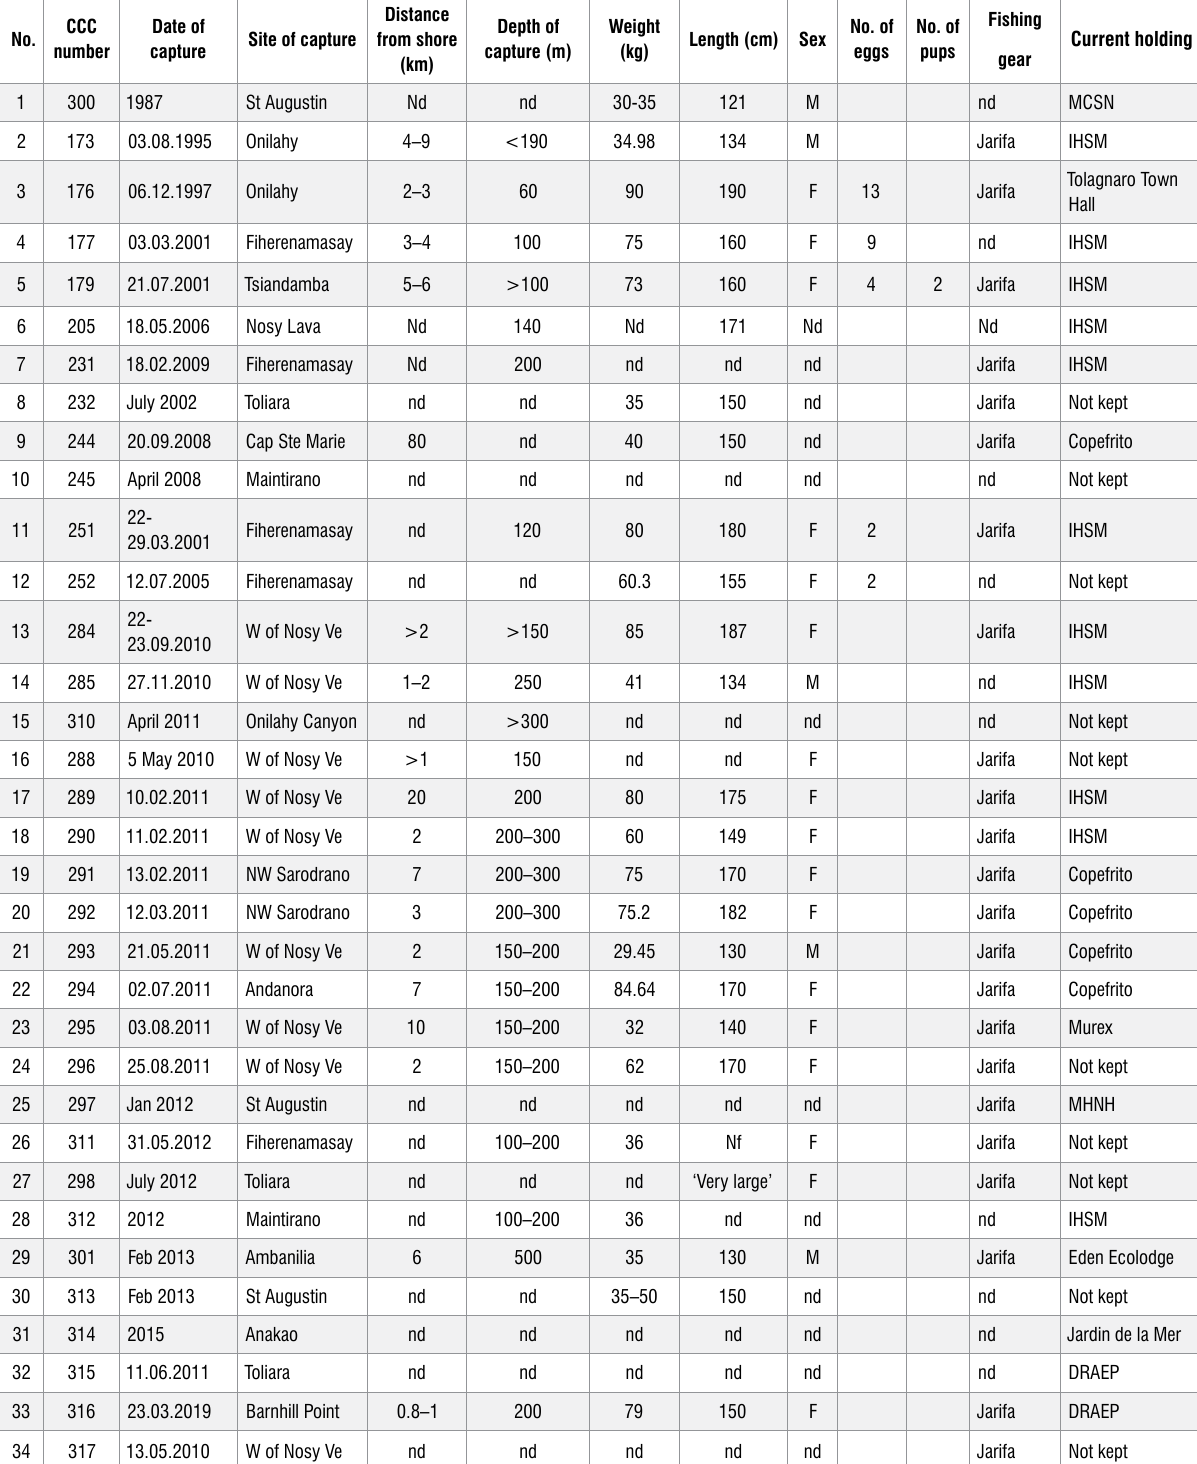
Table 1: Information on the coelacanths known to science caught in Madagascar between 1987 and 2019. Additional information on these specimens is given in the text and full details are given in Cooke et al. 28